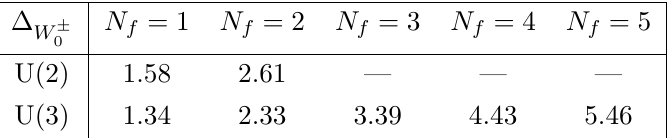
of the double adjoint theory without 0 3 are absent because Tr X 4 f ≥